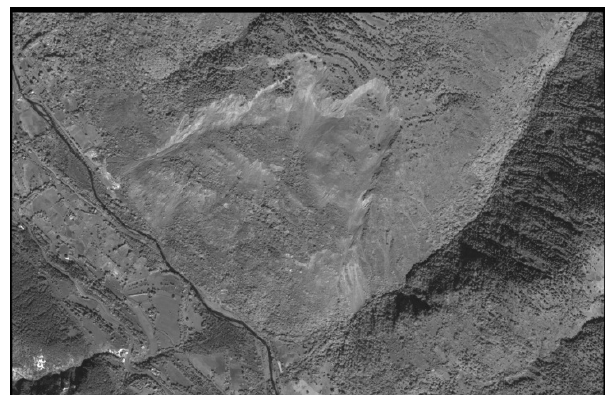
Figure 4. A section of the QuickBird panchromatic satellite image (1,600 m × 2,430 m) over the La Clapière landslide taken on 06 September 2003, North to the